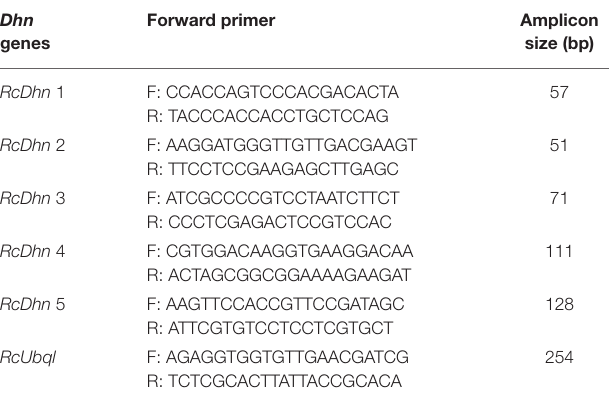
TABLE 1 | Primer sequences for regular and real-time